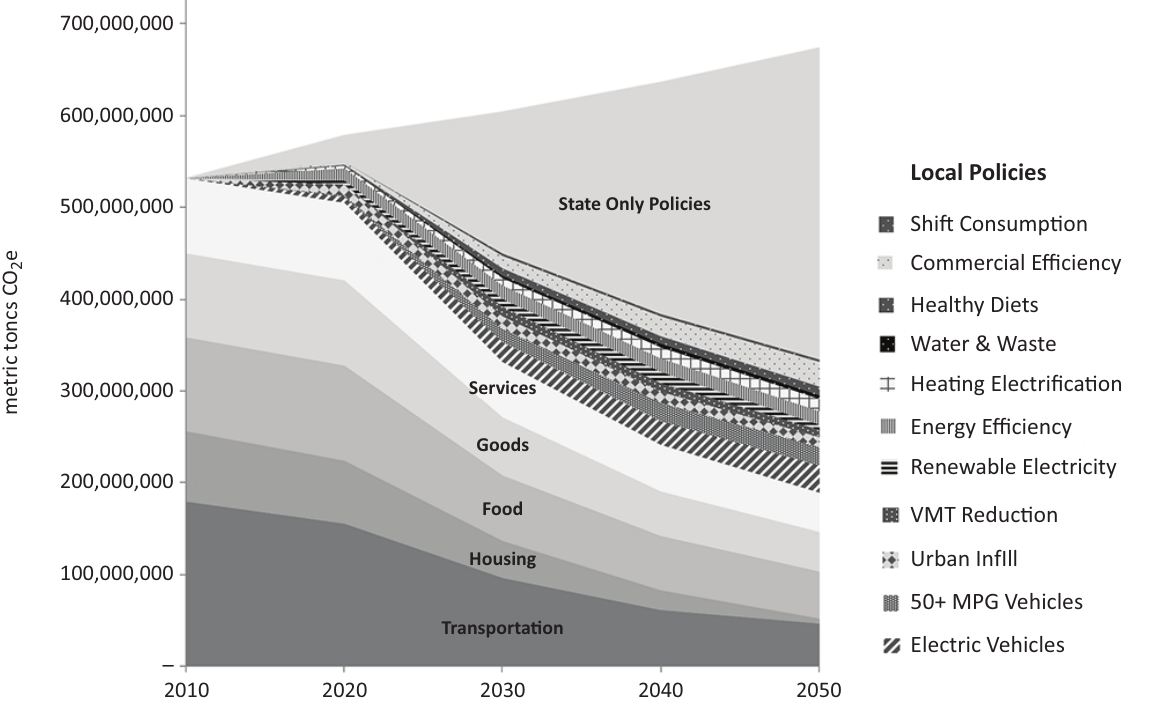
Figure 3. Carbon footprint abatement opportunities from local and state polices for state of California. Table 3. Local GHG abatement potential in 2030 (million metric tons CO